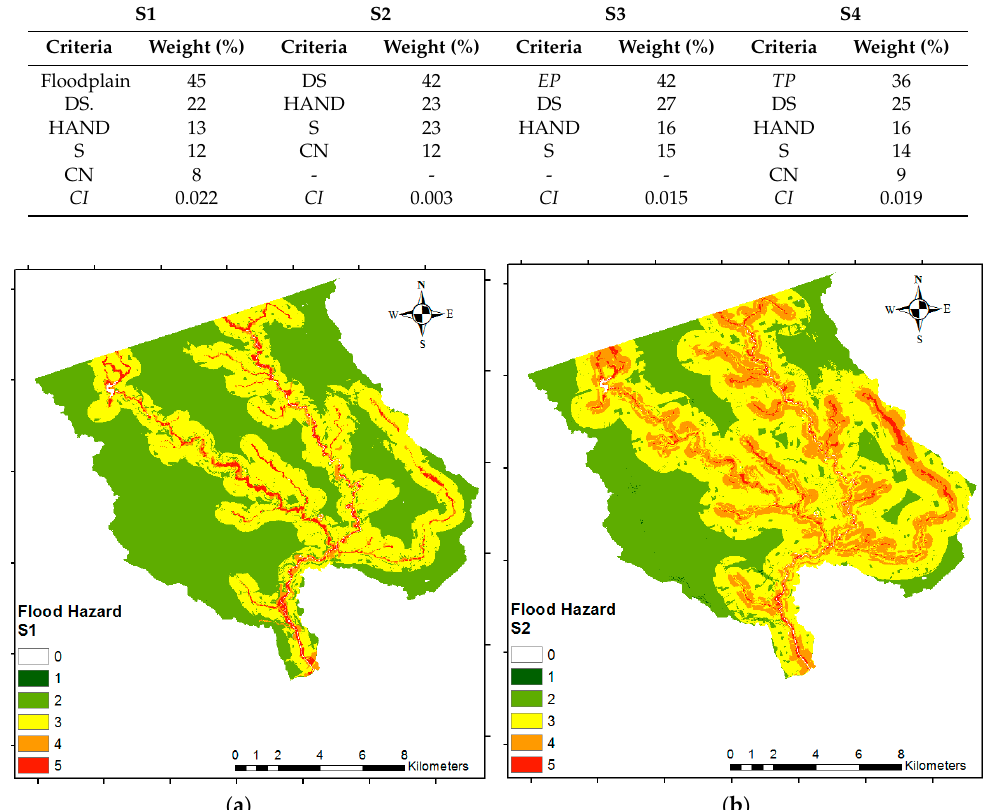
( d ) Figure 6. Flood hazard maps; ( a ) S1; ( b ) S2; ( c ) S3; ( d ) S4. 3.2. Generation of Vulnerability Maps The weights of social vulnerability (shown in Table 11) were assigned to the corresponding criterion to generate the social vulnerability map (Figure 7a). As the economic vulnerability is based on only one criterion (land use), no pairwise comparison was needed to calculate the weights. Instead, the classes established in Table 5 were used directly (with the results presented in Figure 7b). The weights of total vulnerability for each scenario are shown in Table 12. Finally, the total vulnerability maps (shown in Figure 8) for each scenario, V1, V2, and V3, were derived from the combination of social vulnerability and economic vulnerability, by applying the weights determined for each scenario (Equation (5)). These figures show that the economic vulnerability has a higher impact on the total vulnerability: there are relatively more high total vulnerability zones when the economic vulnerability is given higher priority as compared to when social vulnerability is given higher priority.